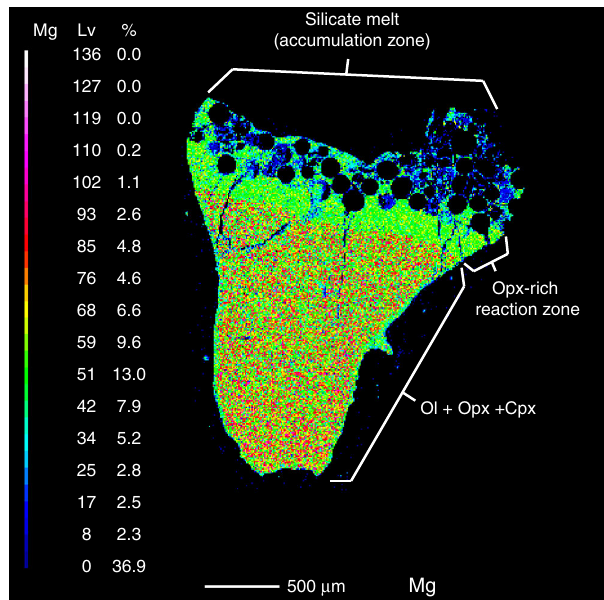
Fig. 3 Mg compositional map of a representative experiment, PER-SERP (85 – 15), performed at 1.5 GPa and 1315 °C. An opx-rich reaction zone was observed along the interface between the melt pool and the residual minerals (green band). PER-SERP experiments produced hydrous melt + ol + opx + cpx at all temperatures investigated